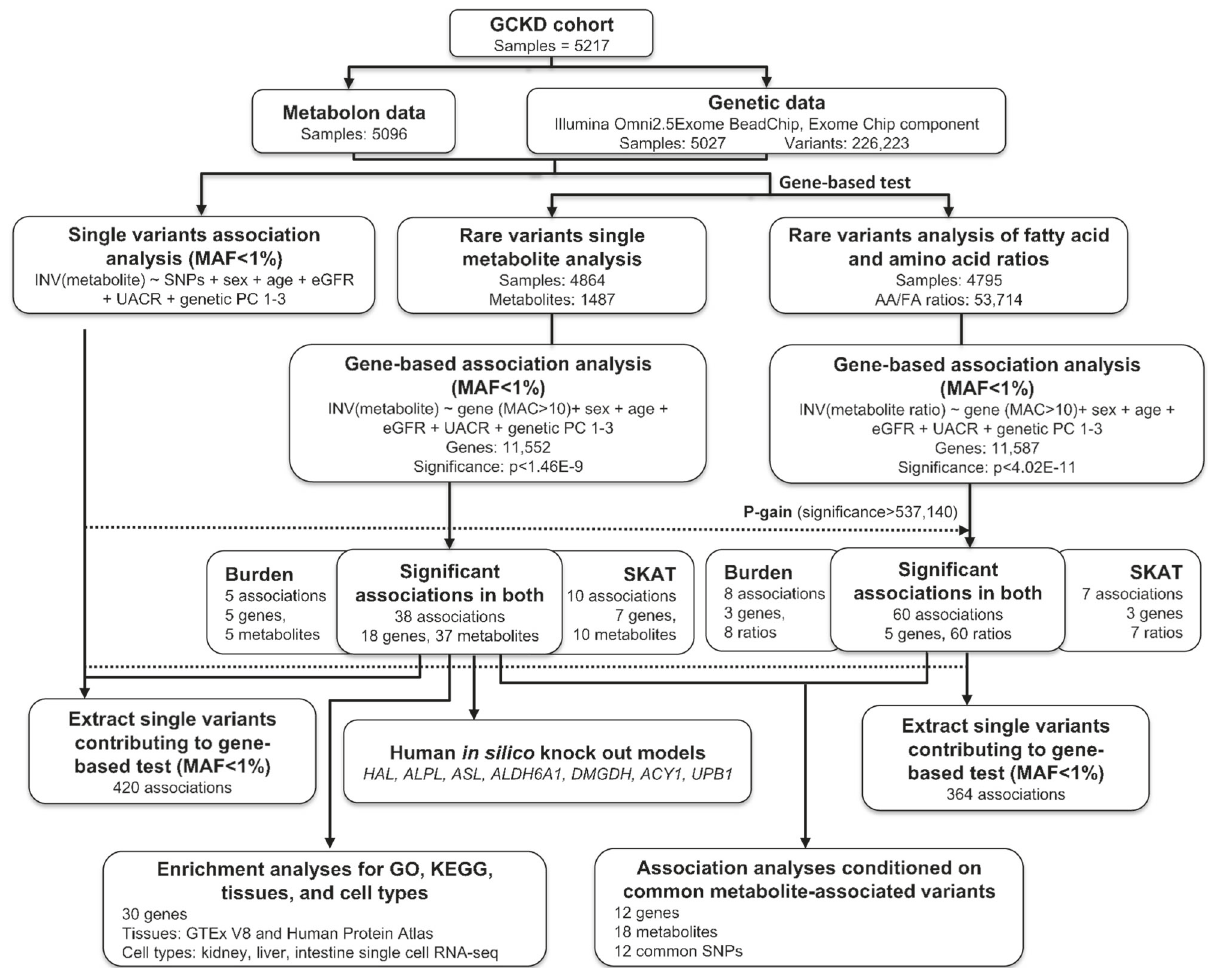
Fig. 1 Rare variant analysis work fl ow. The GCKD study enrolled 5,217 patients with moderate CKD. Non-targeted metabolite identi fi cation and quanti fi cation were conducted from urine samples using the Metabolon HD4 platform. Genotyping was performed with the Illumina Omni2.5Exome Chip. After quality control and data cleaning, genotypes of 226,233 exome chip variants and 1487 metabolites and 53,714 ratios of fatty acids and amino acids were analyzed for 4864 and 4795 patients, respectively. A burden test and the sequence kernel association test (SKAT) were carried out for each gene and each metabolite or metabolite ratio using the seqMeta R package (Methods). Carrier status of variants with minor allele frequency <1% and likely to be functional (splicing, nonsynonymous, stop gain, and stoploss) was evaluated. We used an additive genetic model and adjusted for sex, age, eGFR, UACR, and principal components. Statistical signi fi cance was de fi ned using a Bonferroni correction and set at 1.46E − 09 (single metabolites) and 4.02E-11 (ratios). Ratio results were further fi ltered by a p -gain of >537,140 to select ratios that carry information beyond its single metabolites (Methods). The same model was applied to obtain single variant association results for the variants included in the gene-based tests. In silico knockout models to validate fi ndings were generated in a Virtual Metabolic Human. Enrichment analyses of signi fi cant genes were carried out using GO terms, KEGG pathways, and gene expression data from tissues and cell types. Conditional analyses were carried out to assess the effect of nearby common metabolite-associated variants on the fi ndings from this study. MAF: minor allele